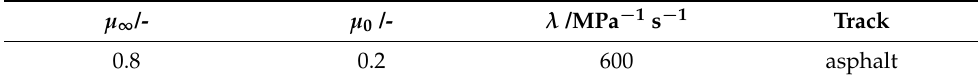
Table 6. Model parameters for the friction law.